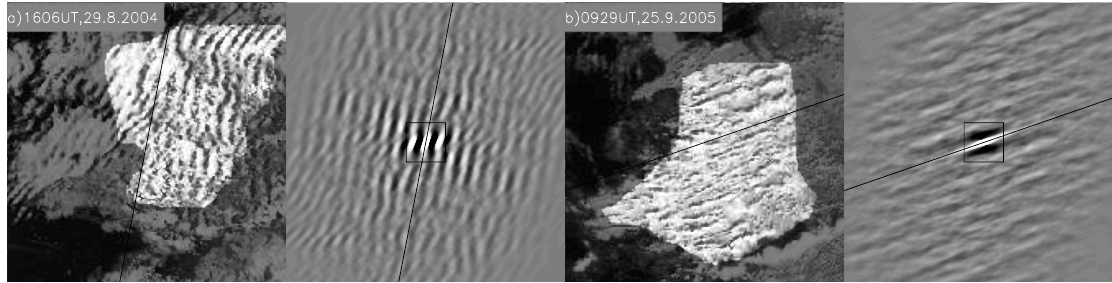
Fig. 11. Example satellite images of (a) mountain waves, (b) convective cloud streets, and autocorrelation of the unshaded areas of cloud. North is at the top. Diagonal lines show cloud azimuth from the region of autocorrelation marked by a square.